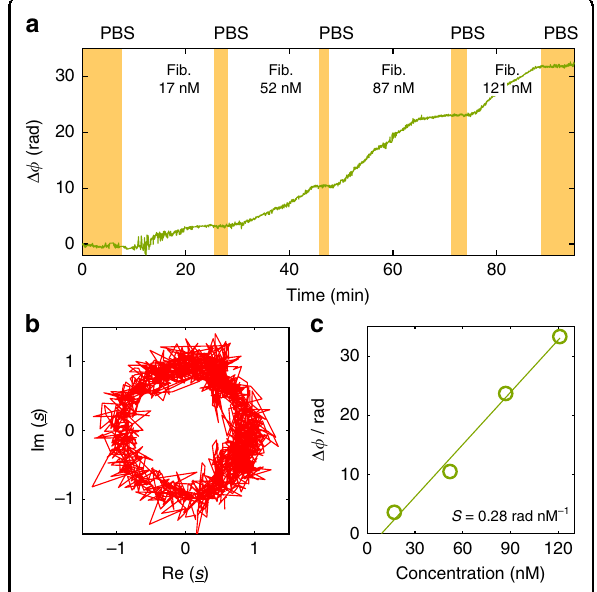
Fig. 6 Demonstration of a sensor with SiNOH lasers as light sources, used for detection of fi brinogen dissolved in a phosphate-buffered saline (PBS) solution. a Binding curve, indicating the measured phase shift Δ ϕ as a function of time. During the time intervals marked in white, PBS solutions with fi brinogen concentrations of 17, 52, 87, and 121 nM are injected into the fl uidic chamber. After each injection of a certain solution, pure PBS is used to fl ush the chamber during the time intervals indicated in yellow. For each concentration, the phase converges to a constant value when binding equilibrium is reached. b Locus-corrected complex Clarke fi eld s for the various detection times in the complex s -plane. More details of the locus correction are provided in Supplementary Note 4. c Phase shift Δ ϕ vs. fi brinogen concentration: The phase shift for each concentration is calculated from the average phase measured during the subsequent PBS fl ushing period. As a reference Δ ϕ = 0 for the phase shift, we use the average phase measured during an initial PBS fl ushing period (marked in yellow) in the fi rst eight minutes of the experiment. The phase shift Δ ϕ increases linearly with the concentration, leading to a sensitivity of S = 0.28